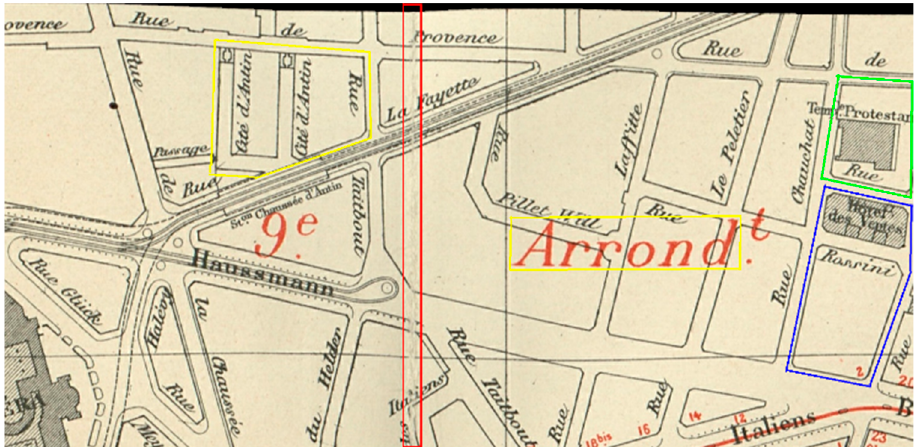
Figure 1. Exemplar challenges in a sample historical map for feature extraction: challenge 1: the shadows represent single buildings and the other has only building boundaries (blue box); challenge 2: building blocks overlap and nest with each other (green box); challenge 3: building blocks are covered by other map contents (yellow box); challenge 4: creases and damage (red box).